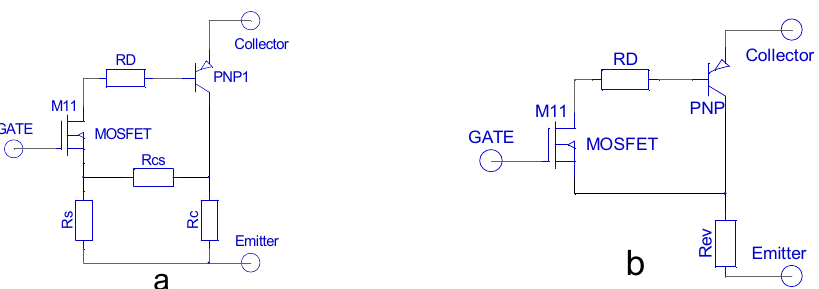
Figure 4. Updated general circuit of the IGBT negative feedback resistor connection schematic in the IGBT ( a , b ) simple versions of this connection.